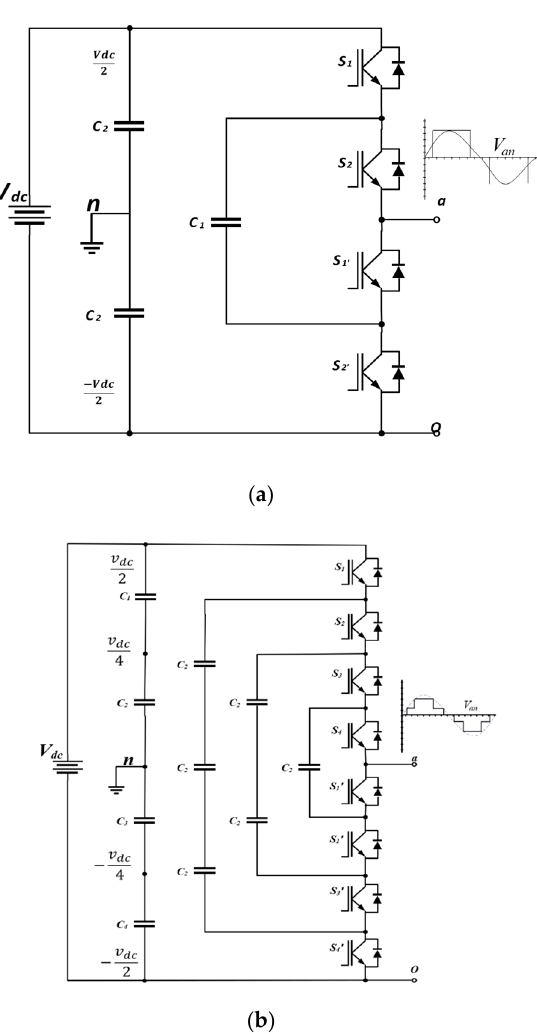
Figure 9. ( a ) Three-level flying-capacitor multilevel inverter (FC-MLI); ( b ) 5-level FC-MLI.